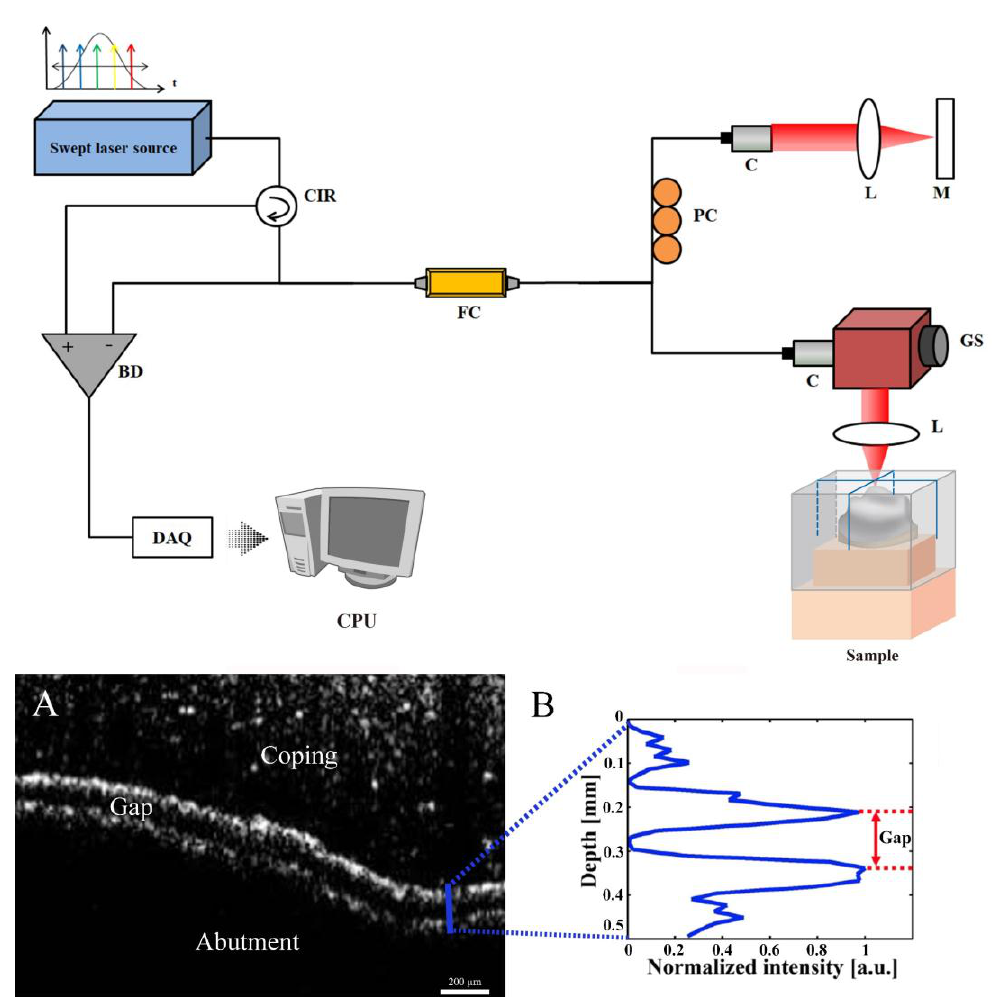
Figure 8. Schematic of the optical coherence tomography (OCT) from the left. ( A ) This indicates the method for measuring the occlusal region in the cross-sectional image of OCT; ( B ) in the intensity peak graph, the gap was calculated as the distance between the highest peak. BD: Balanced Detector, C: Collimator, CIR: Circulator, CPU: Central Processing Unit, DAQ: Data Acquisition, FC: Fiber Coupler, GS: Galvanometer Scanner, L: Lens, M: Mirror, PC: Polarization Controller.